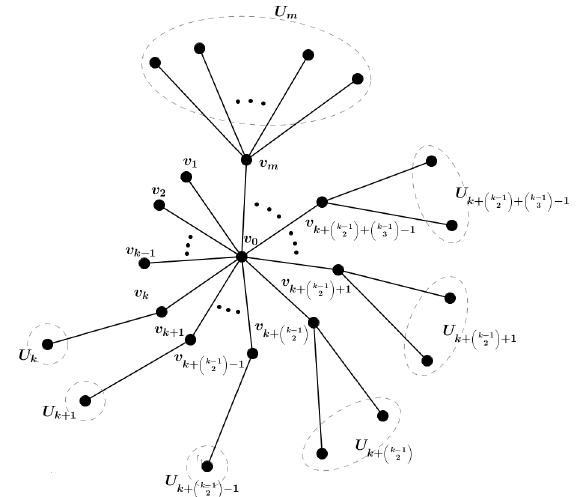
Figure 1: The graph H